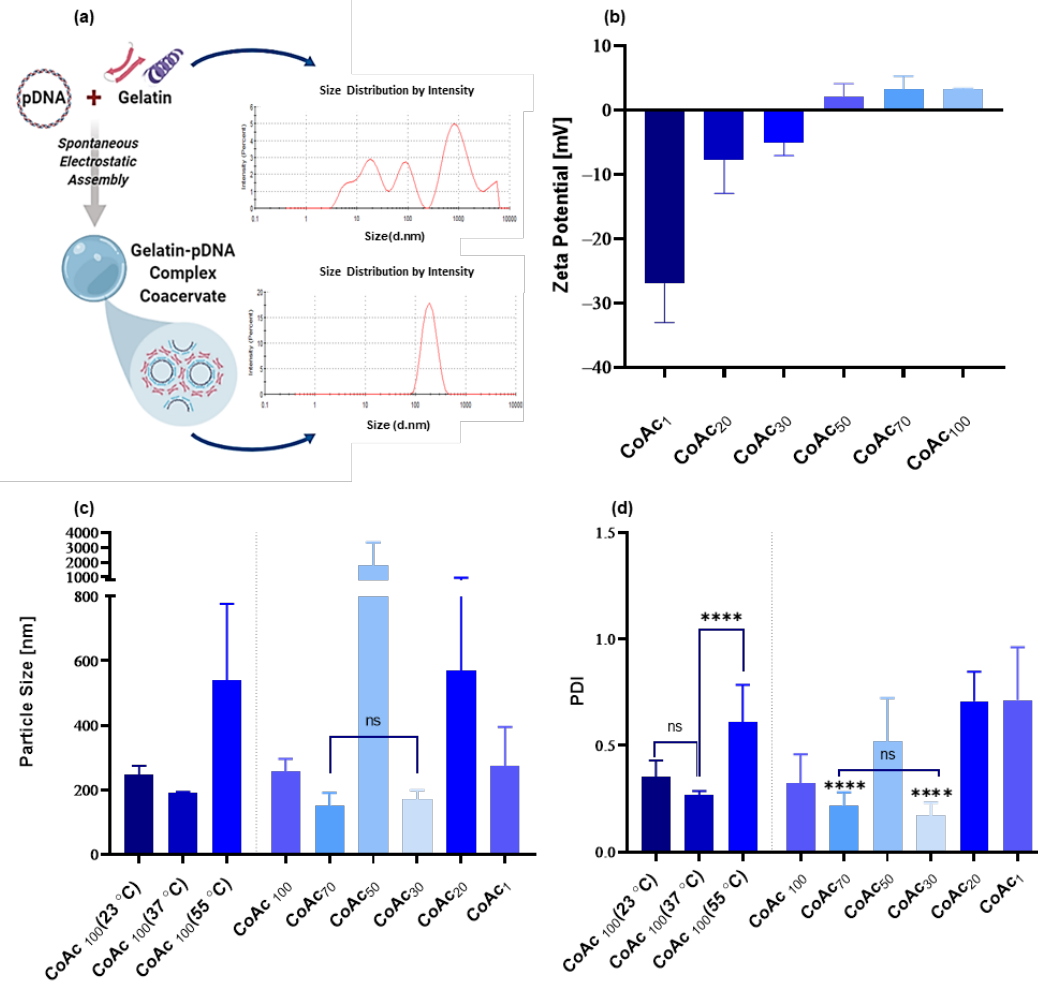
Figure 2. Assessment of the impact of gelatin: pAmCyan mass ratios (of 100, 70, 50, 30, 20, and 1) and coacervate assembly temperature (at 23, 37, and 55 °C) on resulting CoAc using dynamic light scattering. ( a ) The particle size distribution of gelatin A before and after coacervation with pAmCyan in MQ water. ( b ) Zeta potential (mV) of CoAcs ( N = 2, n = 2). ( c ) Particle size (nm) of CoAcs assembled at 37 °C and of CoAc 100 assembled at 23, 37 and 55 °C ( N = 3, n = 3) ( d ) Polydispersity index (PDI) of CoAcs assembled at 37 °C and PDI of CoAc 100 assembled at 23, 37 and 55 °C ( N = 3, n = 3) with statistical significance indicating that present between CoAc 70 and CoAc 30 and other CoAcs. **** p < 0.0001; ns = not significant.